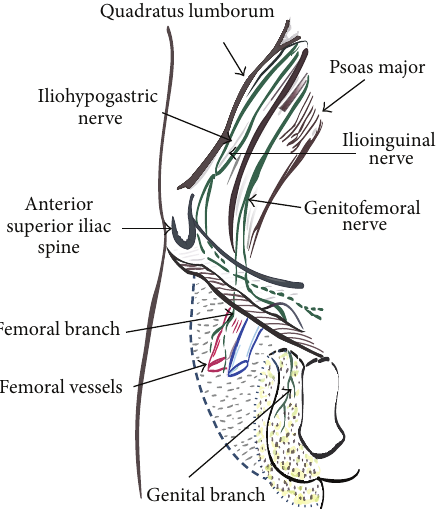
Figure 1: Anatomy of nerves around the inguinal region.